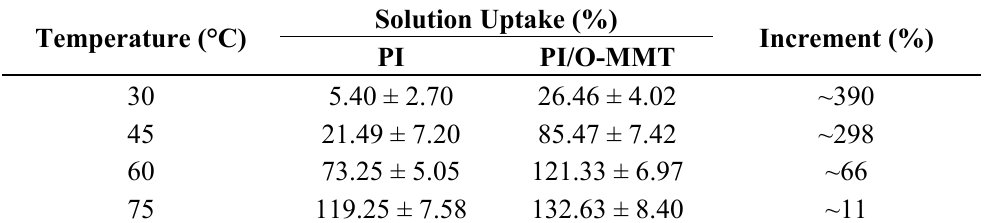
Table 1. Values of solution uptake by PI and PI/O-MMT at different